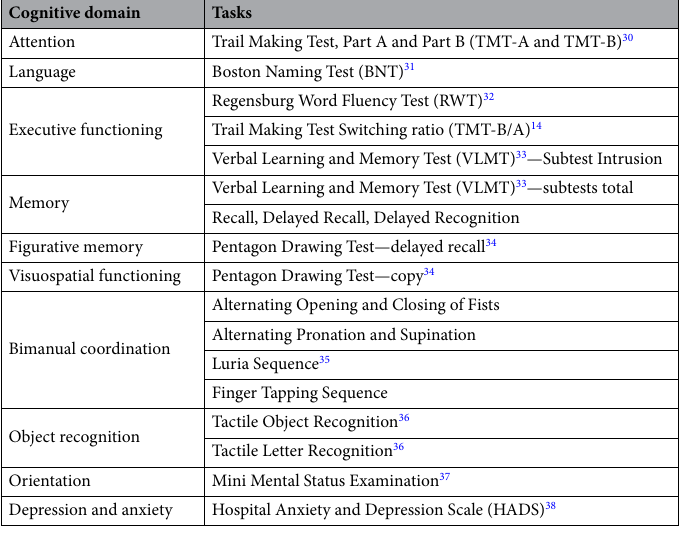
Table 1. Tasks per neurocognitive